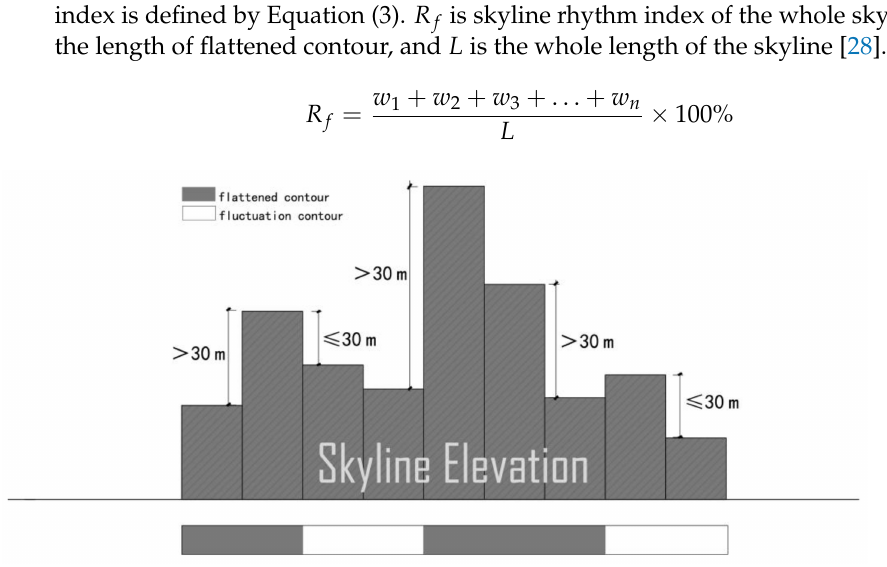
Figure 3. Skyline rhythm